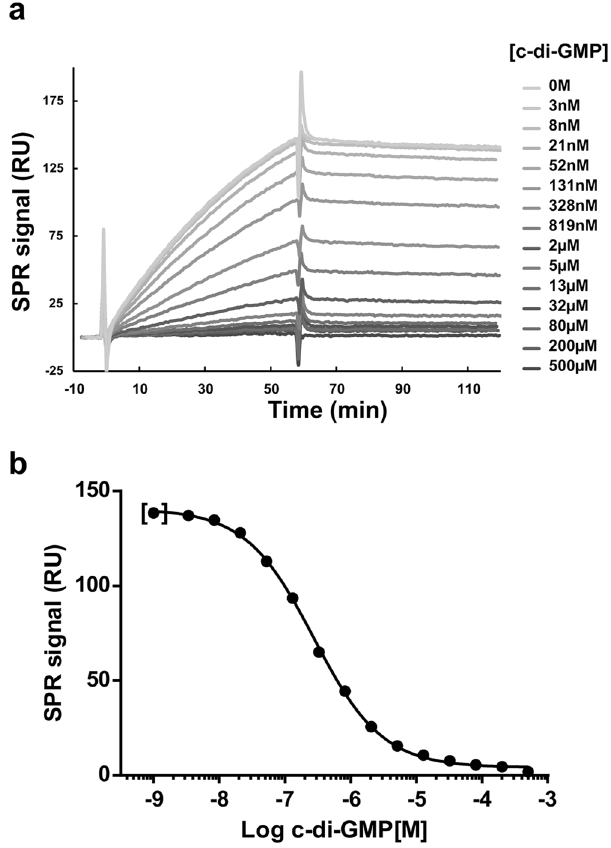
Figure 1. Competition experiments with increasing concentrations of free c-di-GMP in SPR binding assays of C-BgsA to 2 ′ -AHC-c-di-GMP sensor chip. ( a ) Representative SPR sensograms after buffer subtraction of C-BgsA with the different c-di-GMP concentrations. 25 nM of C-BgsA was incubated with increasing concentrations of free c-di-GMP (from 0 to 500 µ M) for 2.5 h and then injected over a high density 2 ′ -AHC-c- di-GMP sensor chip surface. Time point was set up to zero at the injection point. A report point was set directly before the end of the association phase to monitor the SPR signal of each sample. ( b ) The SPR report point represented in ( a ) was plotted against the logarithmic c-di-GMP concentration and the data was fitted with a sigmoidal dose-response curve. First point indicated within brackets corresponds to 0 M of